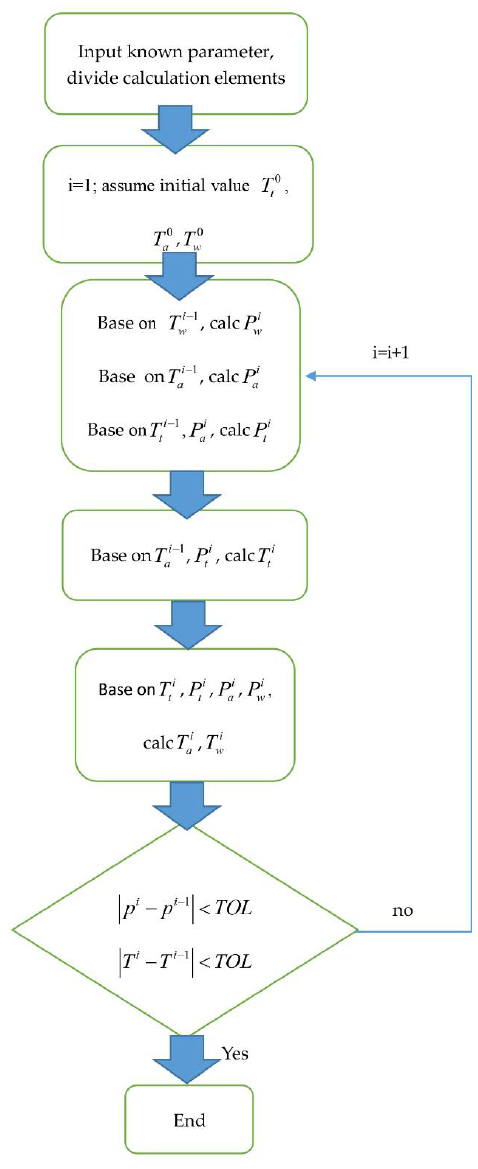
Figure A3. Flow chart of the DHE simulation procedure.